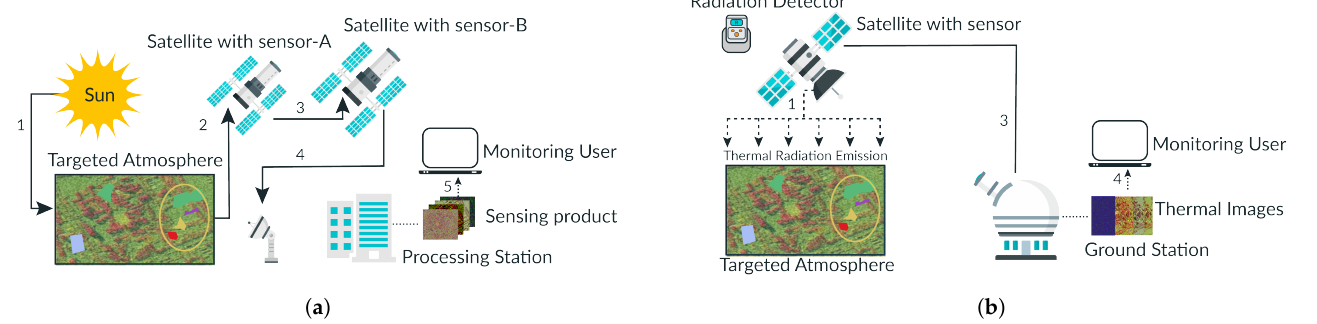
Figure 2. Passive remote sensing processes. ( a ) A passive remote sensing process using optical remote sensing; ( b ) A passive remote sensing process using thermal remote